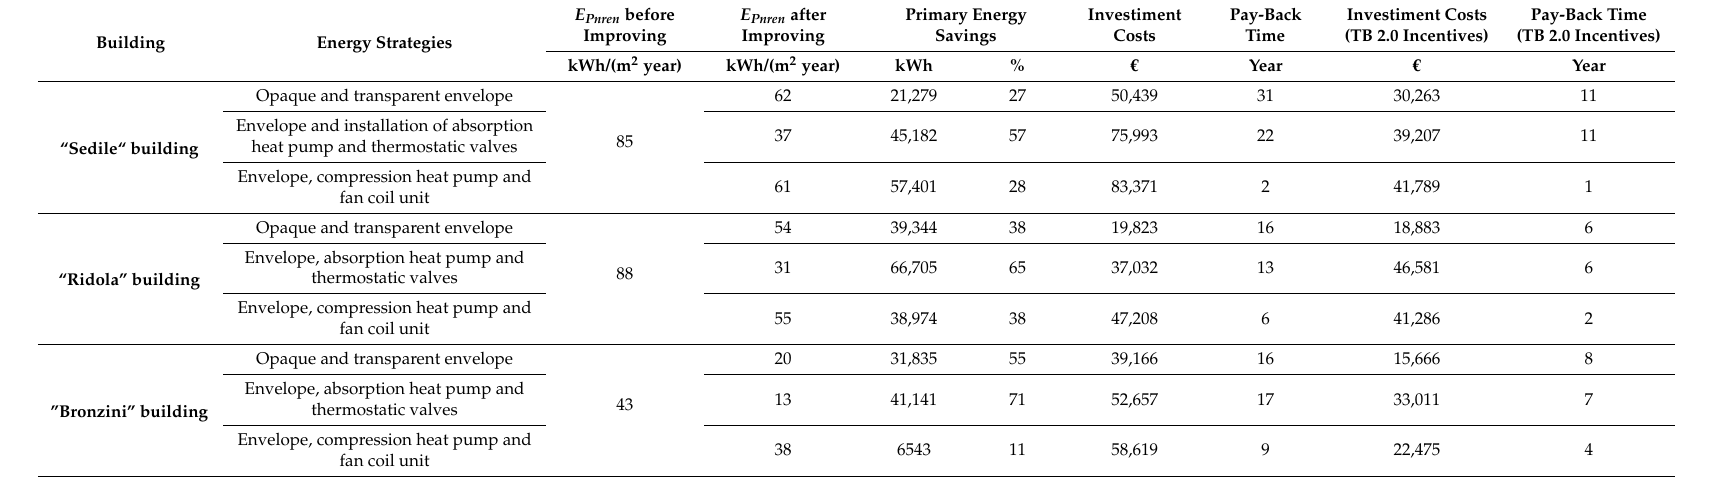
Table 17. Energy saving and pay-back time for combined